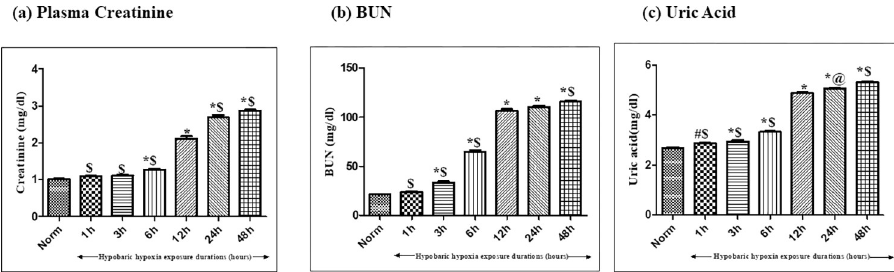
Fig 2. Effect of hypobaric hypoxia exposure on renal function parameters in rats exposed to 7620 m (25,000 ft.) at 25 ± 2˚C for different time durations (i.e. Normoxia control (0h), 1h, 3h, 6h, 12h, 24h and 48h). Values are mean ± SD (n = 6). (a) Plasma Creatinine � p < 0.001 Norm v/s hypobaric hypoxia exposures 6h, 12h, 24h and 48h; $ p < 0.001 hypobaric hypoxia exposure 12h v/s 1h, 3h, 6h, 24h and 48h (b) Blood Urea Nitrogen (BUN) � p < 0.001 Norm v/s hypobaric hypoxia exposures 3h, 6h, 12h, 24h and 48h; $ p < 0.001 hypobaric hypoxia exposure 12h vs 1h, 3h, 6h and 48h (c) Uric Acid � p < 0.001 normoxia control v/s hypobaric hypoxia exposures 3h, 6h, 12h, 24h and 48h; #p < 0.05 normoxia control v/s 1h hypobaric hypoxia exposure; $ p < 0.001 hypobaric hypoxia exposure 12h vs 1h, 3h, 6h and 48h, @p < 0.05 hypobaric hypoxia exposure 12h v/s hypobaric hypoxia exposures 24h. Norm- Normoxia control.